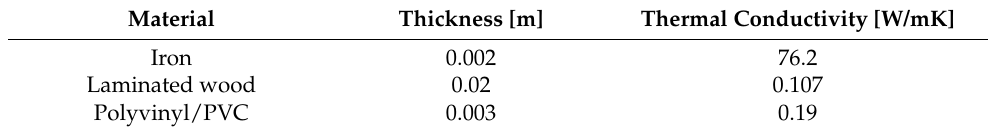
Table 4. The thicknesses and thermal conductivities for the materials of the floor of the bus. Material